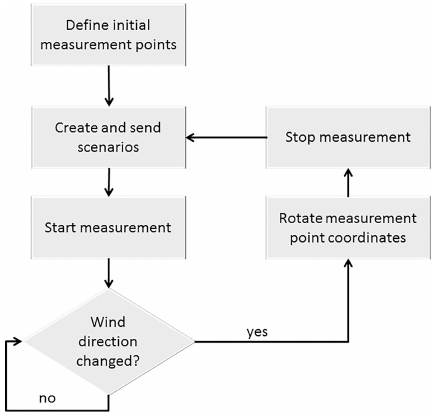
Figure 4. Flow diagram of the automatic adjustment of scanning